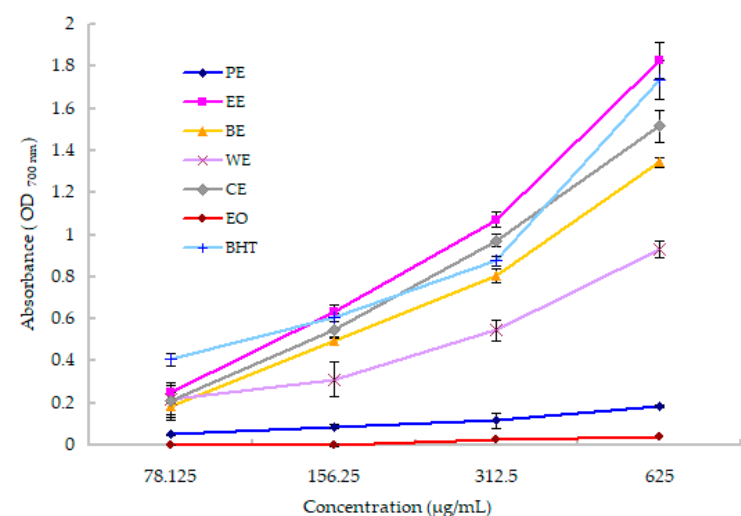
Figure 3. Reducing powers of the essential oil and five crude extracts of R. crenulata. The CE, PE, EE, BE and EO represent the crude extract, petroleum ether extract, ethyl acetate extract, n -butanol extract and essential oil, respectively. BHT is the butylated hydroxytoluene.